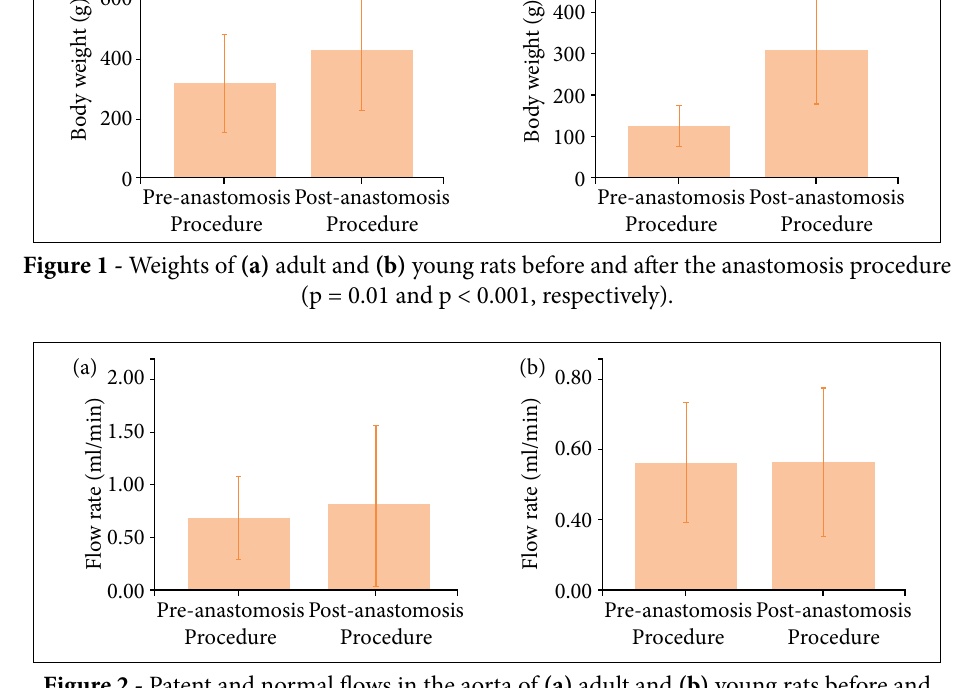
Figure 2 - Patent and normal flows in the aorta of (a) adult and (b) young rats before and after the anastomosis procedure (p = 0.38 and p = 0.90,